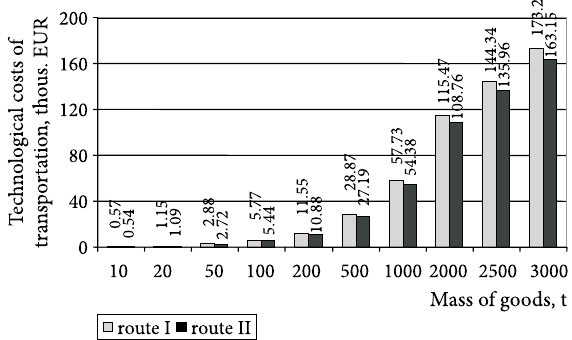
fig. 2. The relationship between technological costs of transportation and the amount of goods carried